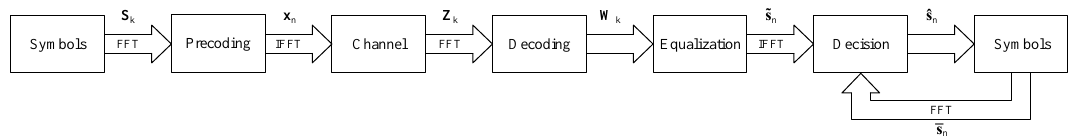
Figure 2. A diagram of the traditional SC system with precoding and decoding, employing an Iterative Block (IB)-DFE)